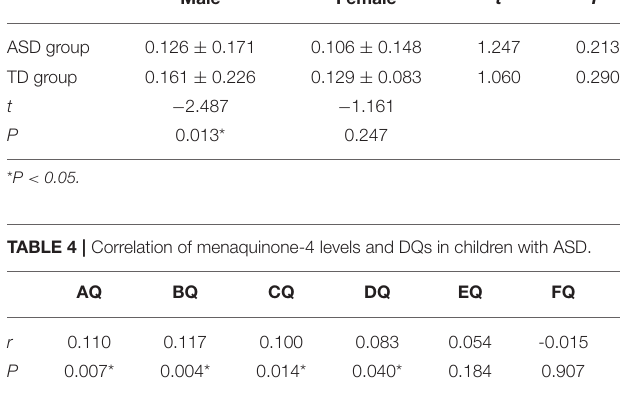
TABLE 3 | Comparison of menaquinone-4 levels between males and females in the two groups. Male Female t P ASD group